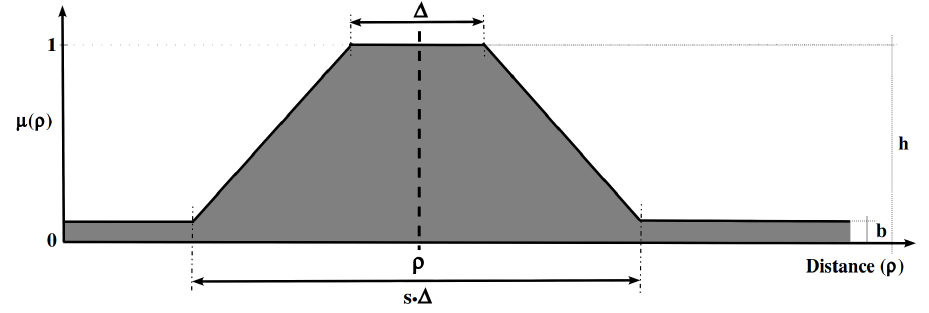
Figure 3. Fuzzy set representation of a position measurement observed at the distance ρ .